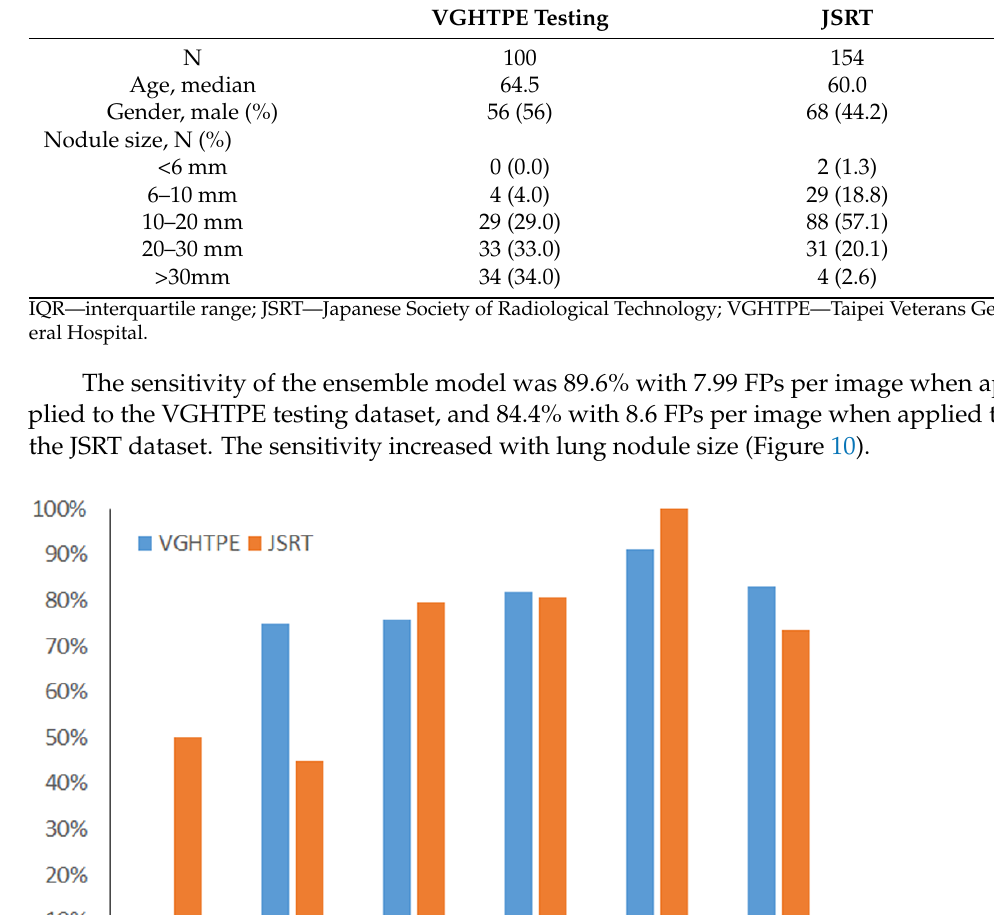
Table 4. Characteristics of the CXRs in temporal